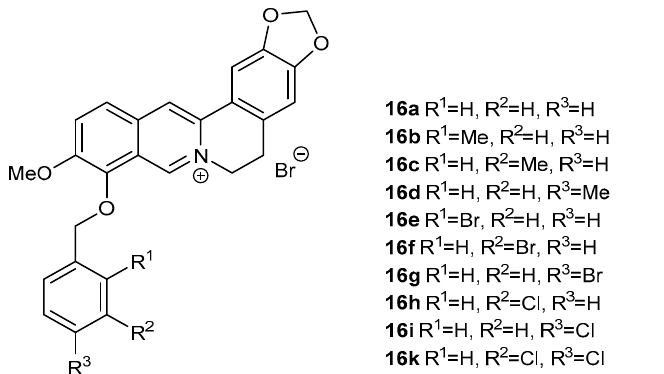
Figure 2. Berberine derivatives from our library investigated as antitubercular agents within this study [28]. study